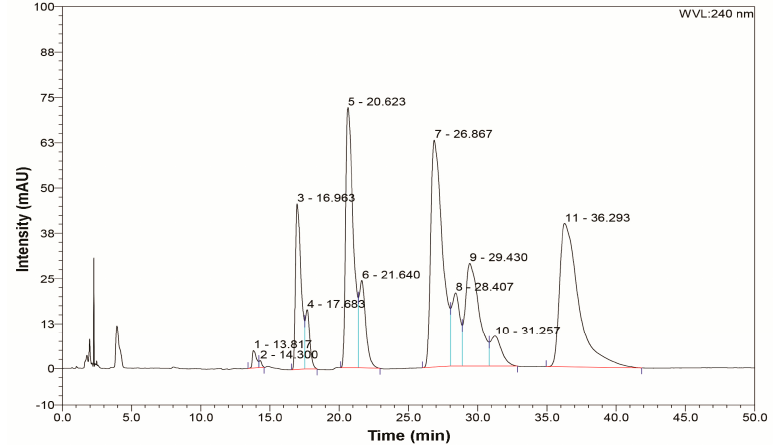
Figure 1. HPLC chromatogram of different dipropyl polysulfides in synthesized mixture.